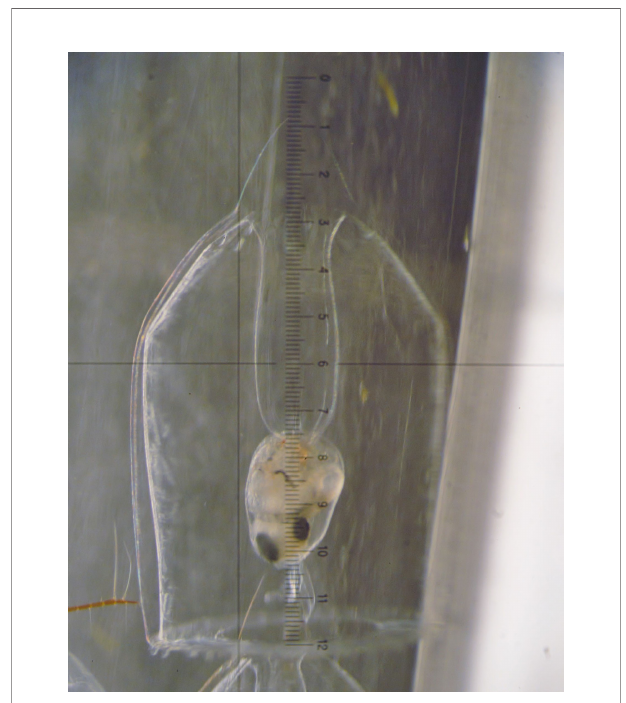
FIGURE 9 | Microscopic observation of Aglantha digitale ingesting a herring larvae. Picture © Carsten